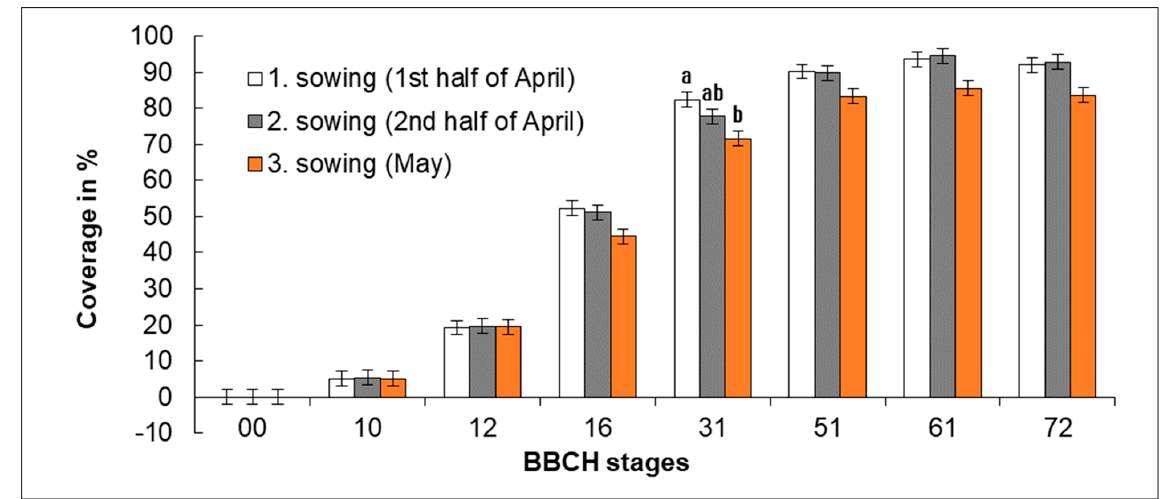
Figure 6. Effect of sowing date on the coverage of plants reached in individual developmental stages. Average values ( n = 9) of individual variants are shown for the specific developmental stages (BBCH) in three years of study ± SD. Different letter indices are added only to variants in which significant differences were found ( p < 0.05).